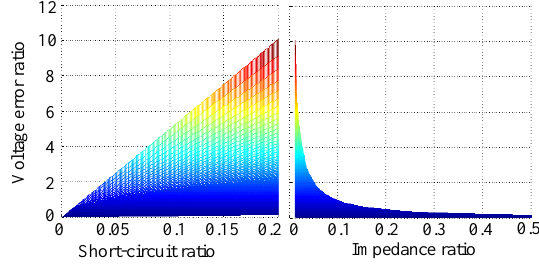
Figure 2. Voltage error ratio under different short-circuit ratios and impedance ratios.